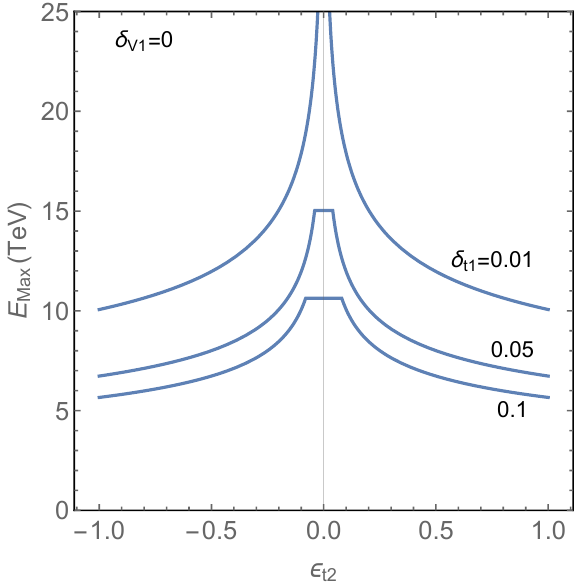
Figure 11 . The unitarity bound from processes that depend on δ t 1 , c t 2 = 3 δ t 1 (1 + (cid:15) t 2 ) where (cid:15) t 2 = 0 is the prediction of the dimension-6 SMEFT operator. Due to these amplitudes depending on coupling δ , it has been set to zero in this V 1